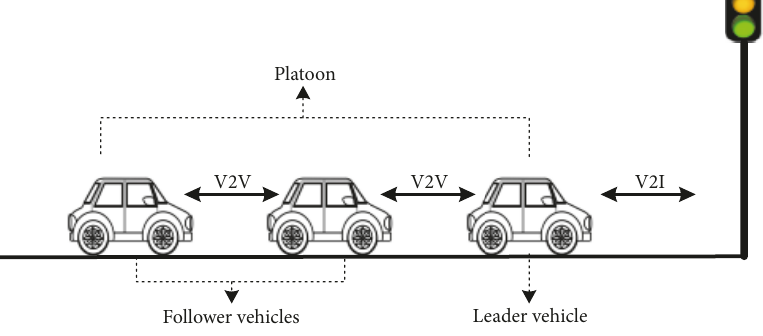
Figure 1: Platoon driving schematic diagram.